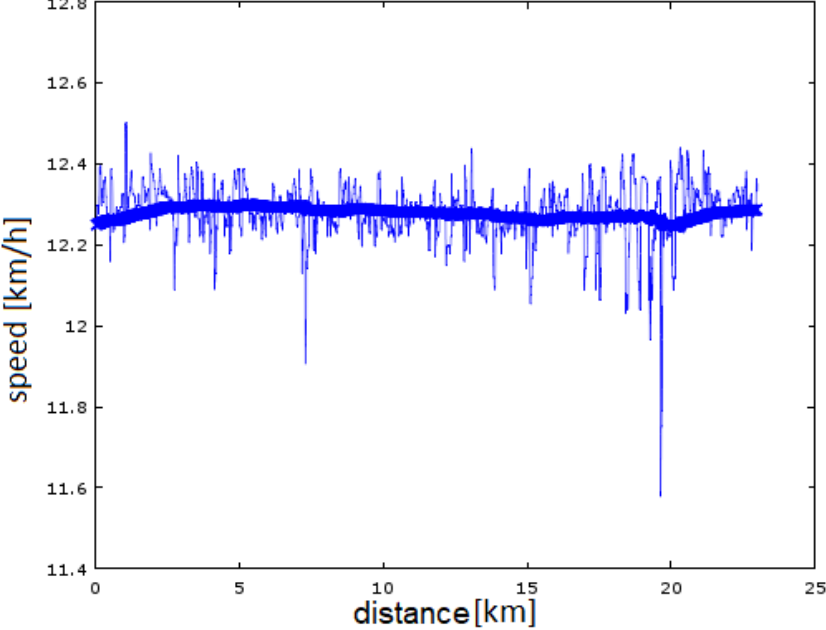
Figure 6. The result of velocity estimation for steady-state running (Polar watch